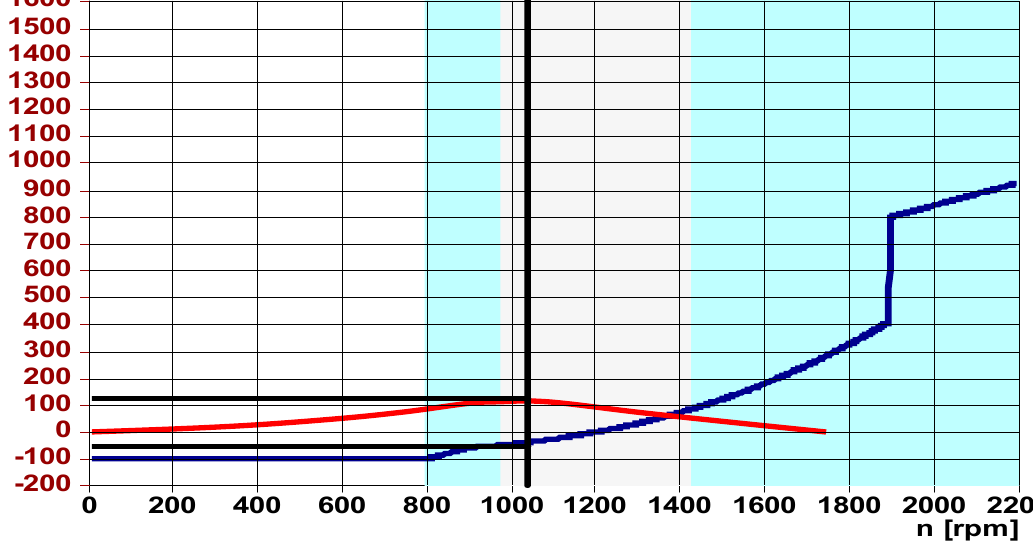
Figure 18. A wind turbine based on DFIG with a speed of 5.2 m/s.